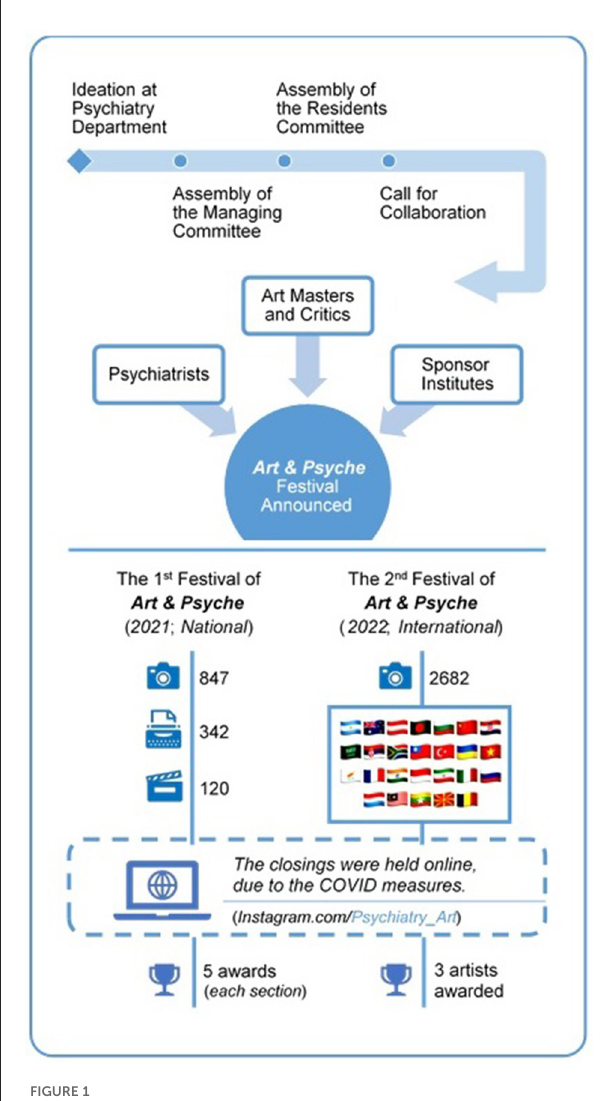
FIGURE1 Process of organizing the “Art & Psyche Festival” from ideation until the closing event.